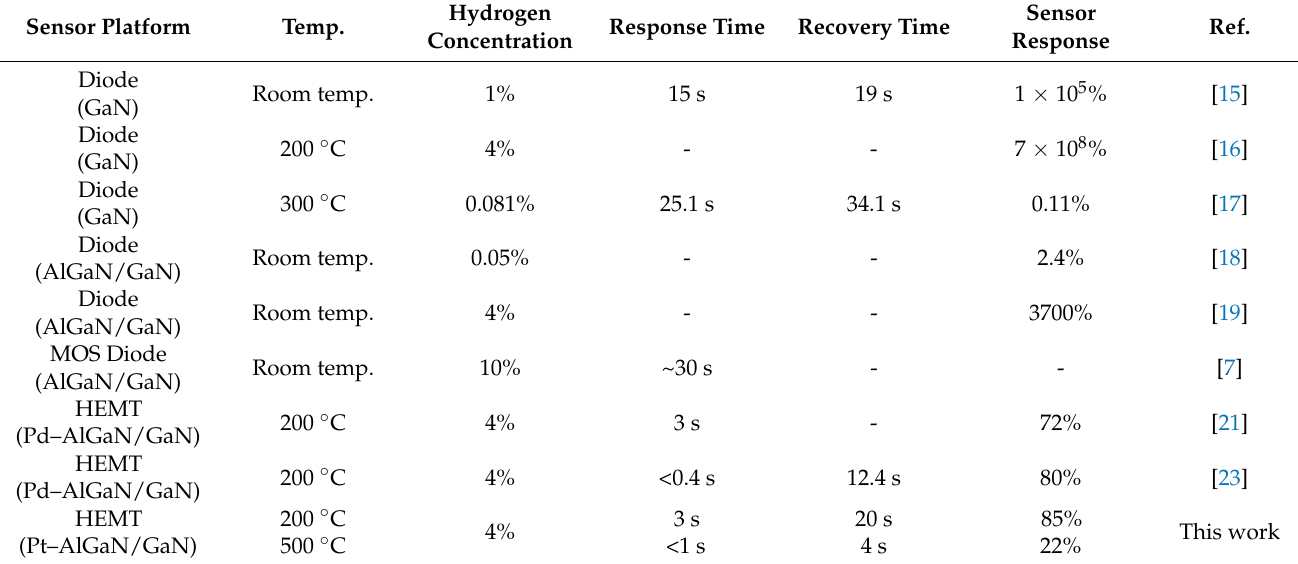
Figure 7. ( a ) Transient-response characteristics at 200 °C of a 2-terminal SCG sensor with a 9 nm-AlGaN barrier. ( b ) The dependence of response on the temperature increase. ( c ) Transient-response characteristics at 500 °C. One cycle with 4% hydrogen in argon injection for 5 s followed by a recovery period. Table 2. Summary of the GaN-based sensor characteristics with previous reports.